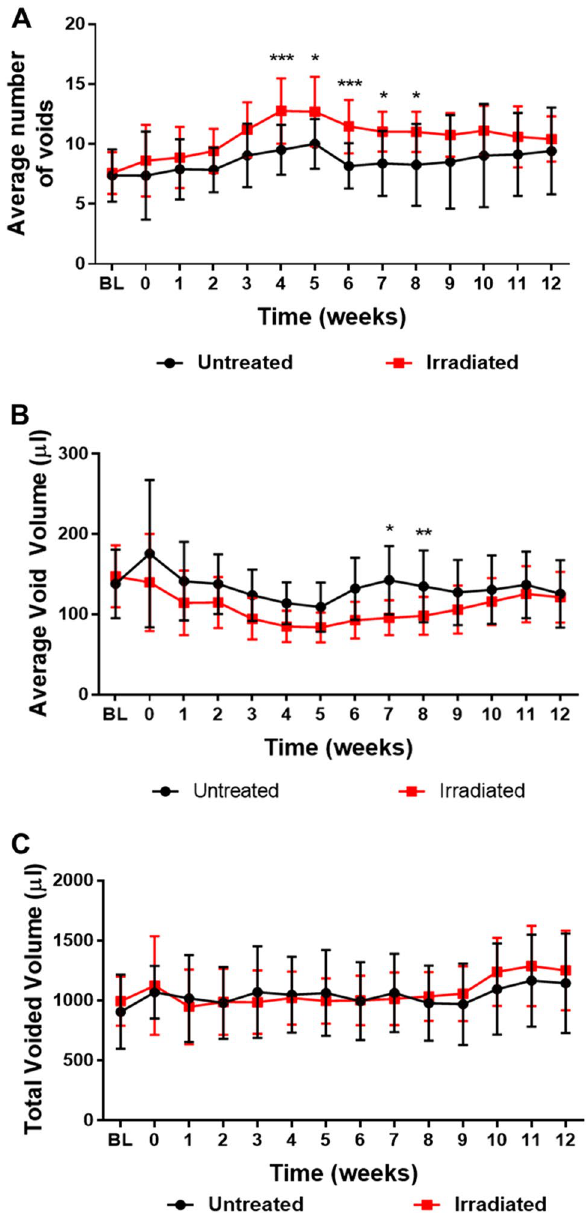
Figure 1. Increased frequency and reduced void volume due to irradiation exposure. ( A ) The average number of voids, ( B ) the average volume per void, ( C ) and the total voided volume were plotted for untreated and irradiated treatment groups from baseline (BL) to 12 weeks post-irradiation. *p < 0.05; **p < 0.01; ***p < 0.001. Error bars =